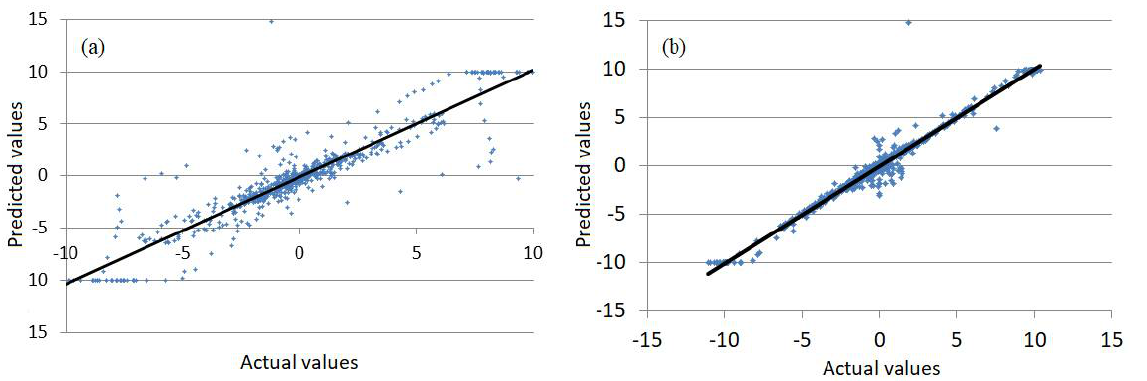
Figure 9. The recorded and computed values of the signal in ( a ) Wavelet-ARIMA and ( b ) Wavelet- ANN model (output from the R software).